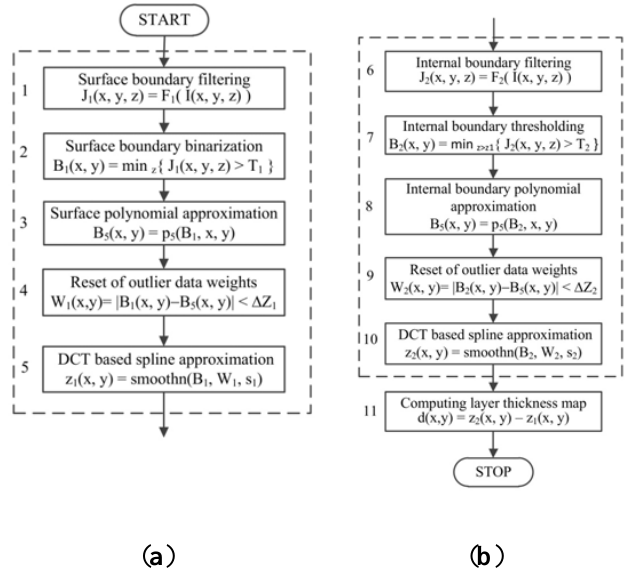
Figure 9. Algorithm flow for measurement of composite layer thickness in a single sample region: ( a ) surface approximation stage (1) ÷ (5); ( b ) internal boundary evaluation stage (6) ÷ (10); I ( x , y , z ) —the original image of the sample region R k [ X × Y × Z ] (Figure 8); J ( x , y , z ) —the filtered image with emphasized boundaries; F 1 ( · ) , F 2 ( · ) —boundary filtering procedures; T 1 , T 2 —the thresholds for boundary detection; B 1 —the set of surface boundary fragments (Figure 10a); B 2 —the set of internal boundary fragments (Figure 10c); (cid:1868) (cid:2873) (cid:4666)∙(cid:4667) —fifth order polynomial approximation in the XY plane;